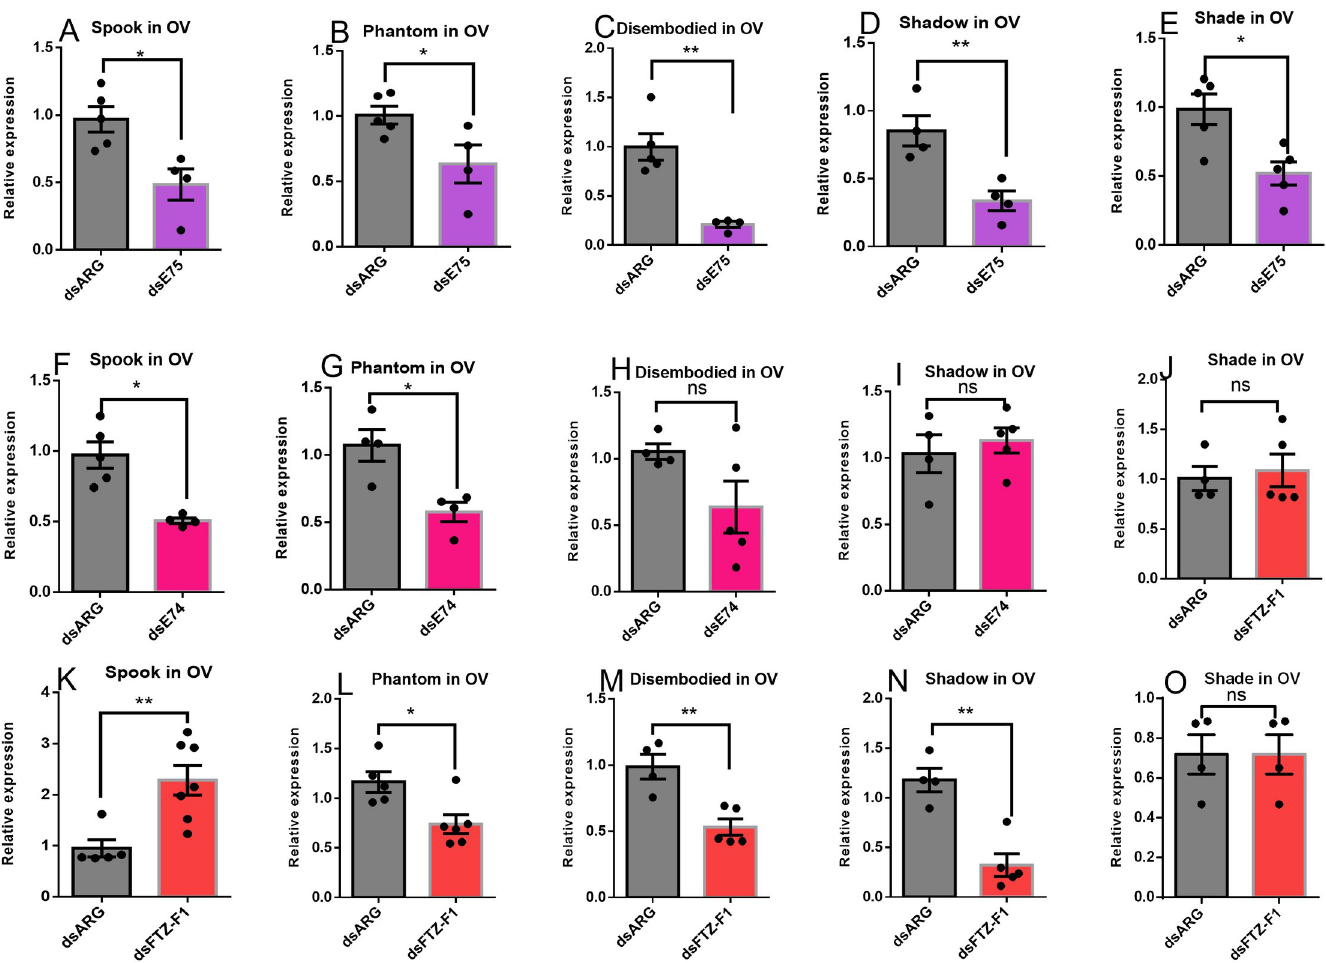
Fig 4. Effects of knockdown of E75 , E74 or FTZ-F1 on transcript expression of Halloween genes ( spook , phantom , disembodied , shadow and shade ) in the ovary of adult females 4 days post blood meal. Females were injected with dsRNA and blood fed as described in Materials and Methods. Relative transcript levels were measured using RT-qPCR and analyzed using the 2 − ΔΔ Ct method. Data are means ± SEM (n = 4–7). Rp49 and β -actin were used as reference genes. Statistical analysis was performed by Student’s t-test. � p < 0.05, �� p < 0.01, ns = not significant.